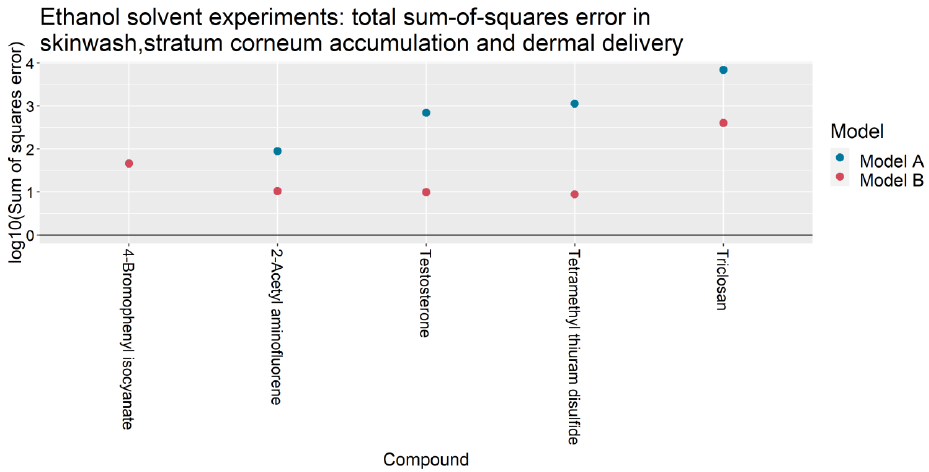
Figure 3. Total sum-of-squares errors 𝐸 𝑇𝑜𝑡𝑎𝑙2 (as defined in Table A4) of Models A and B for IVPTs conducted using a pure ethanol solvent.